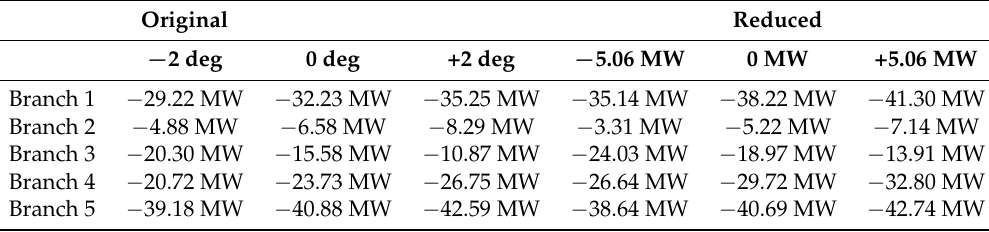
Table 2. Power flows for a PST with ω = ± 2 degree in both the original and reduced